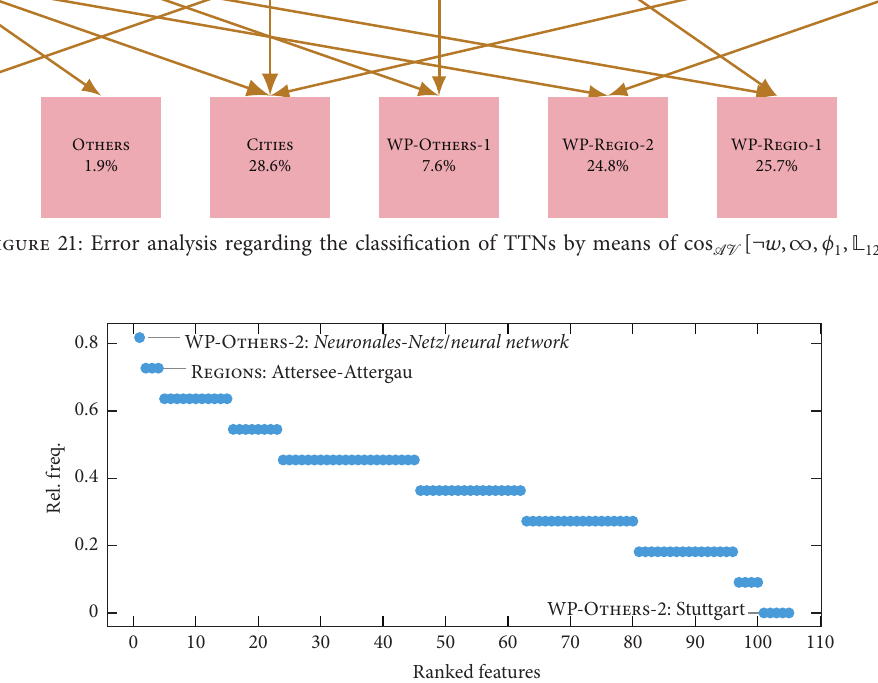
Figure 22: Ranking of the relative frequencies of features as a result of being selected by the extended genetic feature optimization in the classification of TTNs.